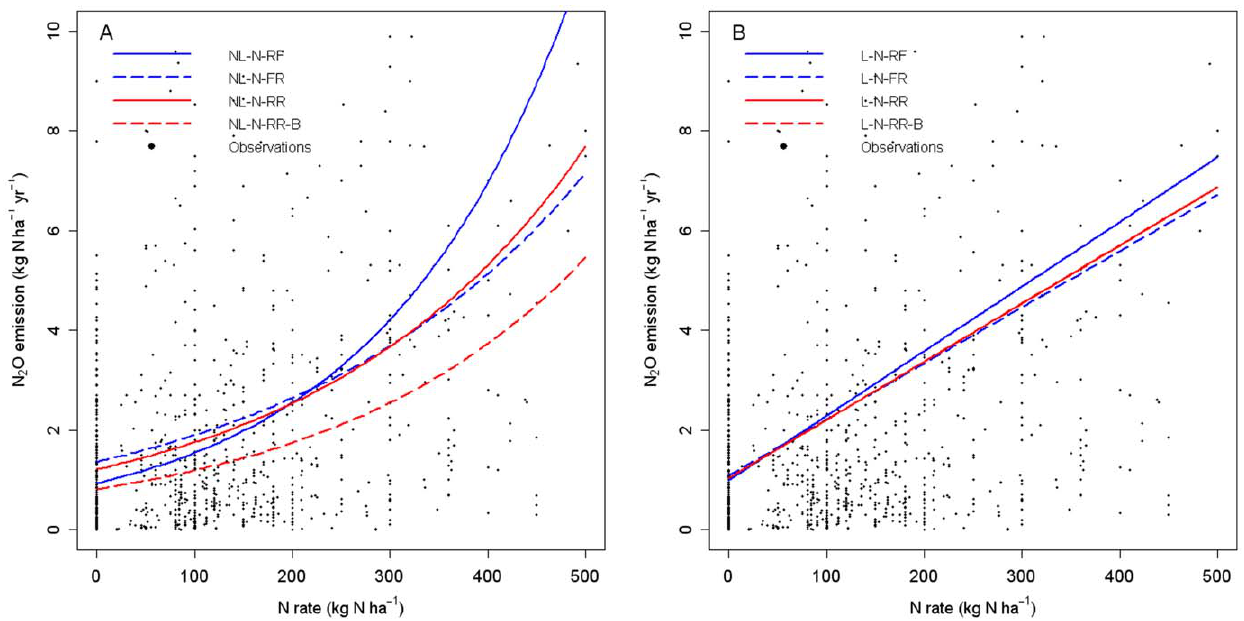
Figure 1. Fitted response curves obtained with the four selected nonlinear models (A) and the four selected linear models (B). Black points correspond to N 2 O data (96.04% of available observations are displayed; the other data are too extreme for graphical presentation).